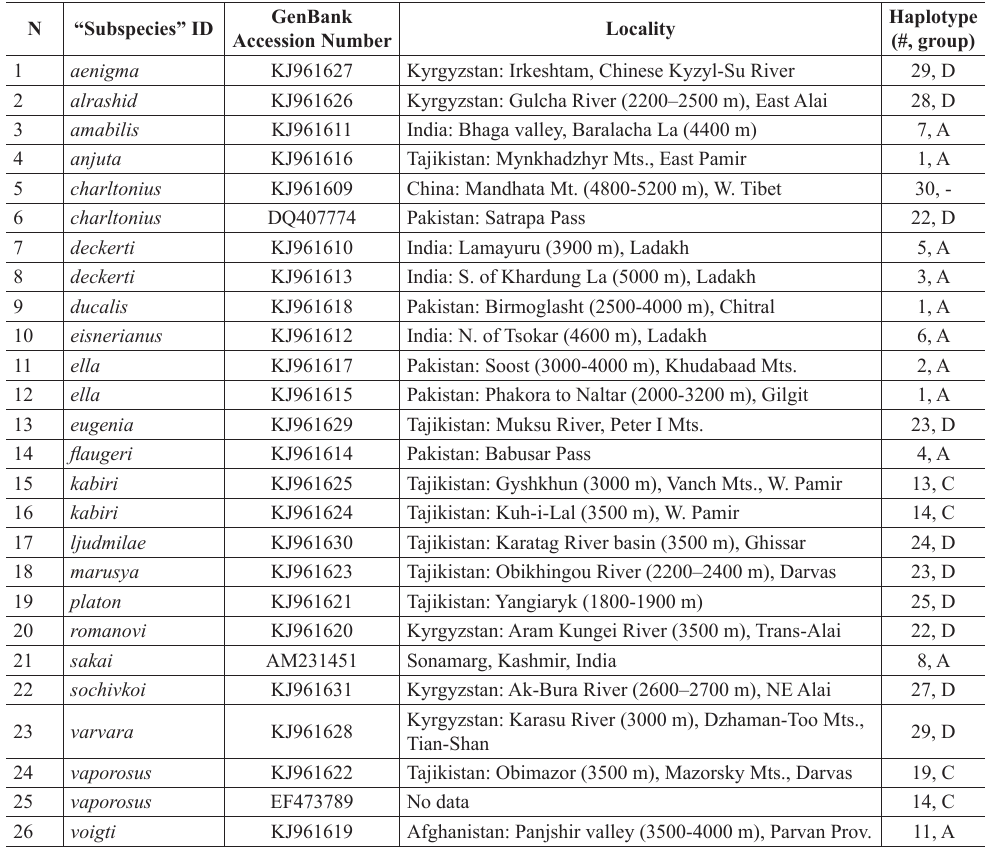
Table 3. Samples of K. charltonius from GenBank used in current